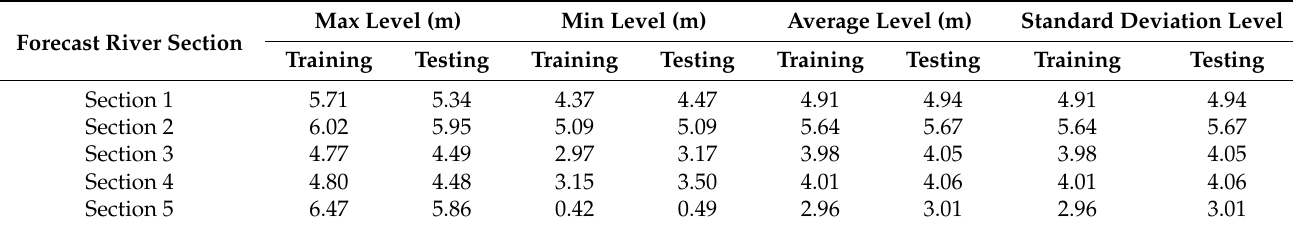
Table 1. Statistics of observed water levels in the training period and the testing